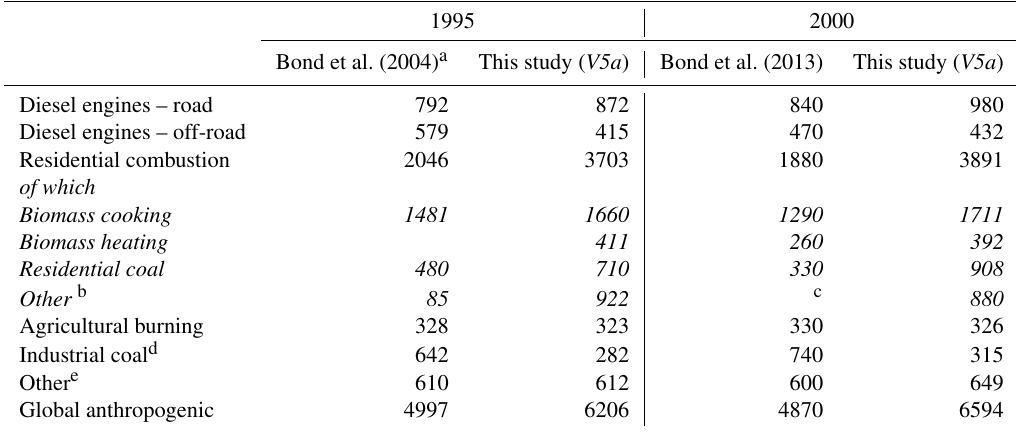
Table 9. Comparison of global anthropogenic emissions of BC by sector, Ggyear − 1 . Numbers in italic refer to key contributing sources in the residential combustion sector.